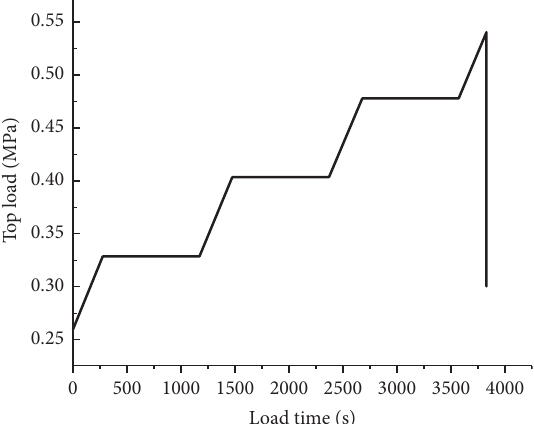
Figure 8: Curve of top load versus time for unsupported